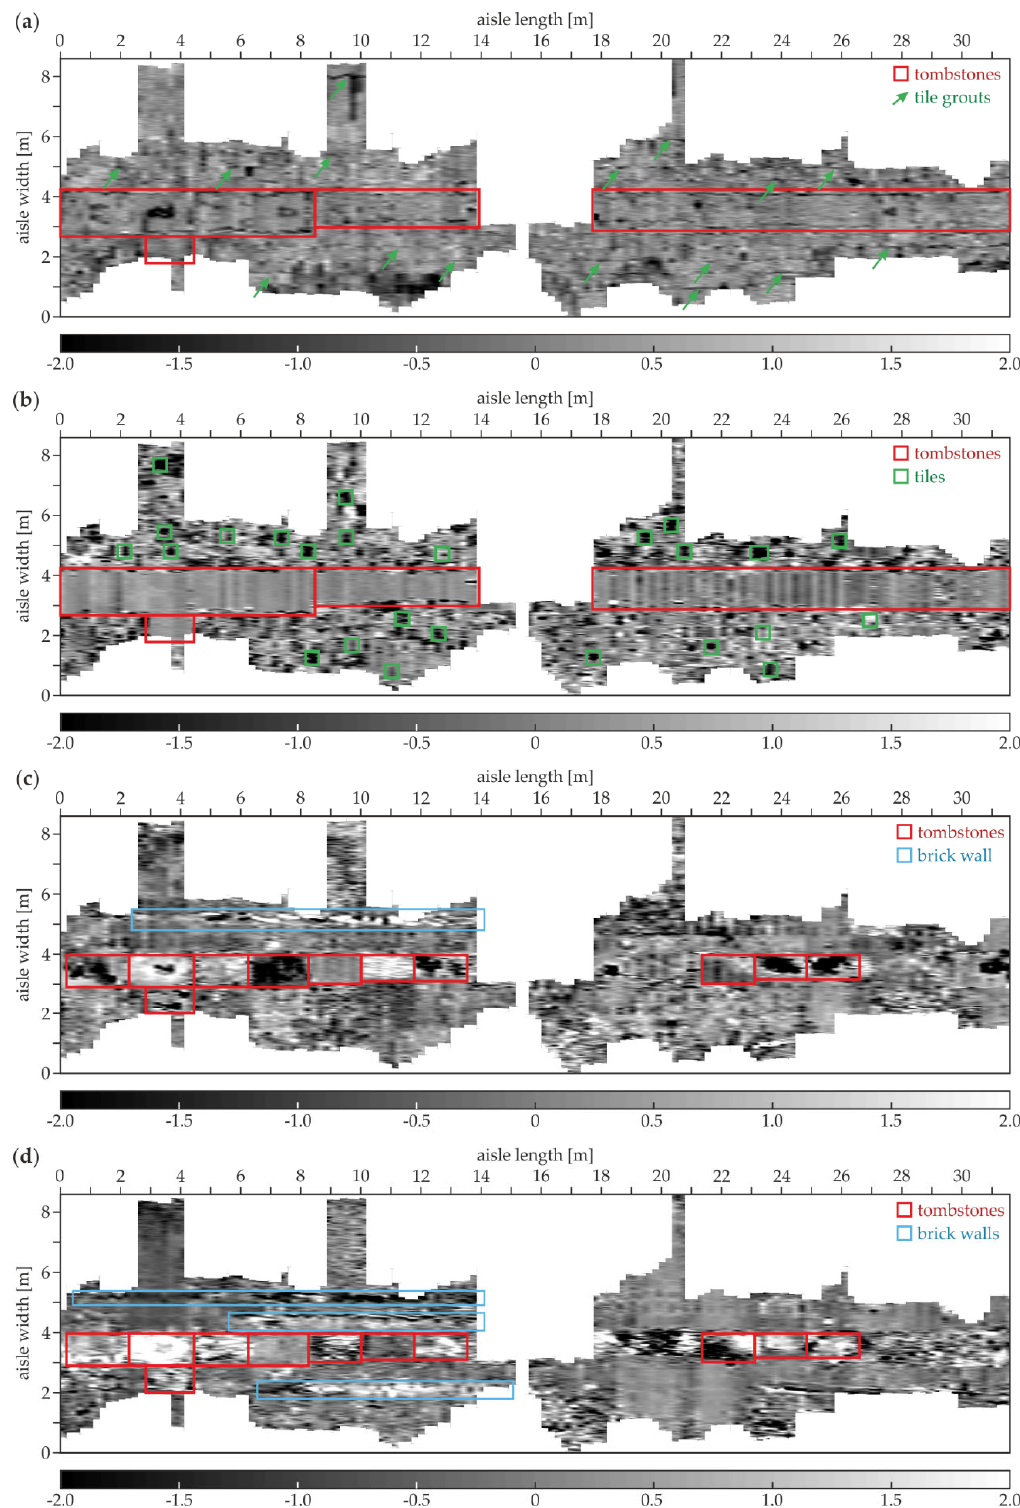
Figure 21. GPR tomographic images of the south aisle (survey A) at different depths: ( a ) 0.16 cm; ( b ) 4.06 cm; ( c ) 12.19 cm; ( d ) 23.75